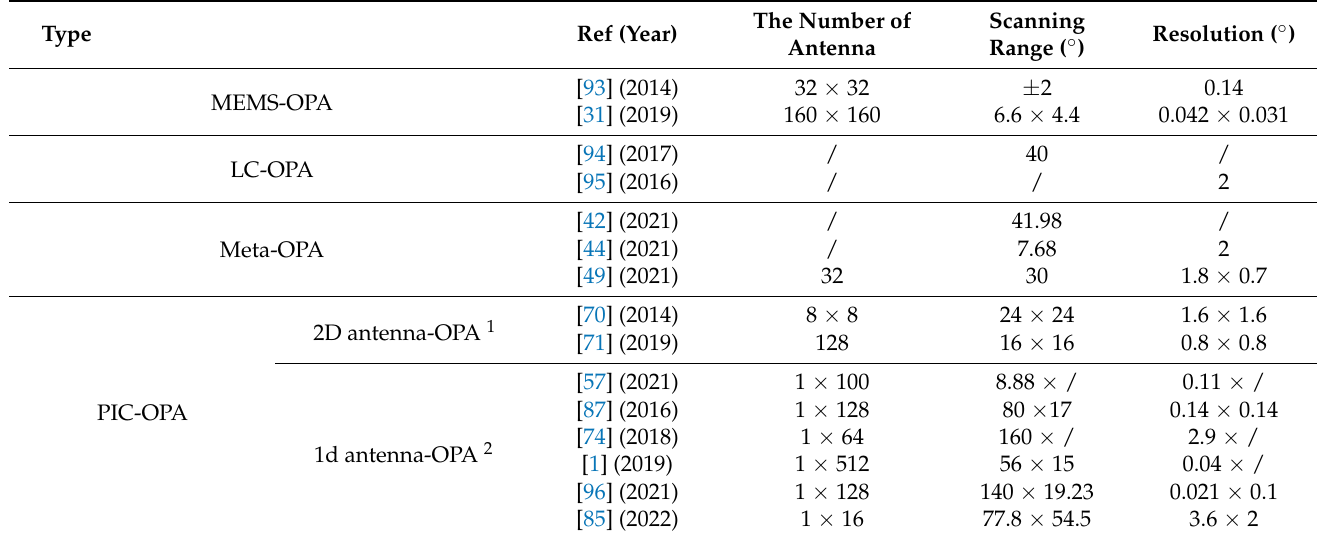
Table 1. The performance comparison of the recently demonstrated